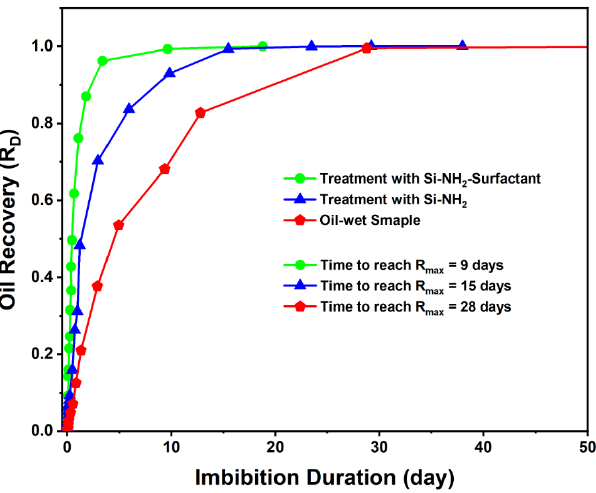
Figure 13. Normalized spontaneous imbibition curves for the three tests. on the parameters listed in Table 4 for analytical comparisons of the results. Table 4. The characteristics of the carbonate samples and fluids used in spontaneous imbibition experiments.